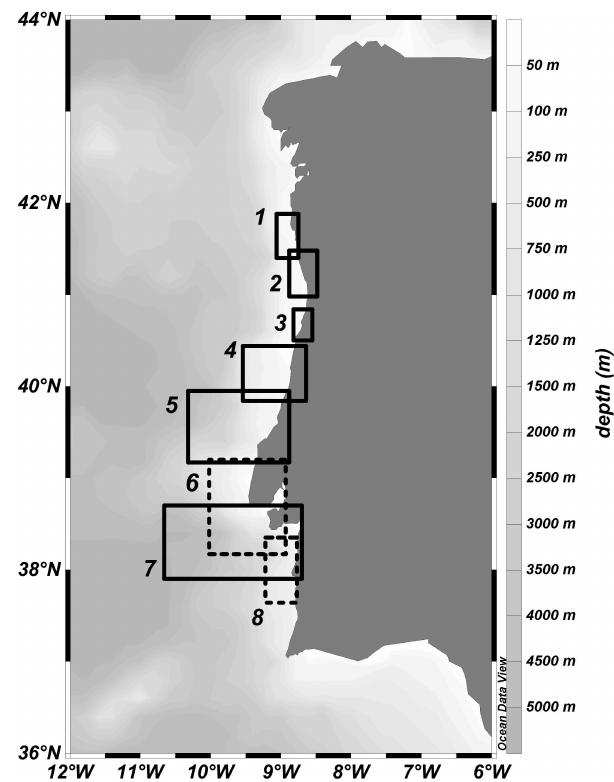
Fig. 12. Smaller scale and local model applications that use the results from MOHID-PCMOS as lateral boundary conditions, ei- ther in hindcast or forecast simulations: (1) Viana do Castelo, (2) Leix˜oes, (3) Ria de Aveiro, (4) Mondego estuary and adjacent coastal area, (5) Nazar´e canyon, (6) Tagus coastal area, (7) Set´ubal canyon, and (8)